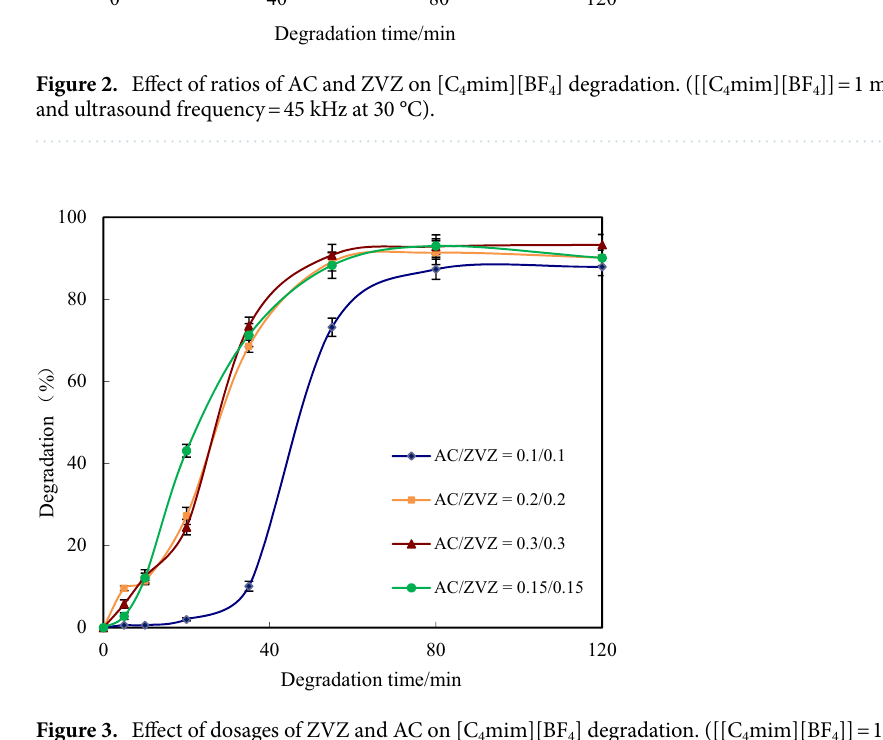
Figure 3. Effect of dosages of ZVZ and AC on [C 4 mim][BF 4 ] degradation. ([[C 4 mim][BF 4 ]] = 1 mmol/L, pH = 3.0 and ultrasound frequency = 45 kHz at 30